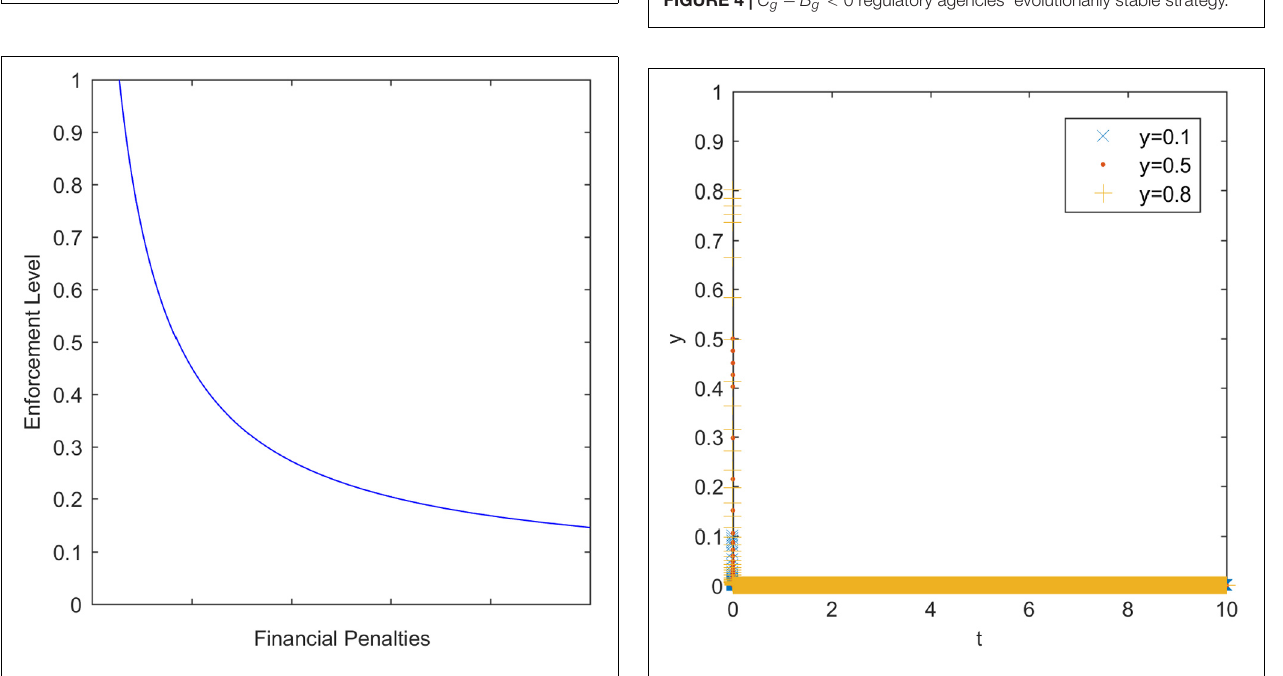
FIGURE 5 | C g − B g > B + F g regulatory agencies’ evolutionarily stable